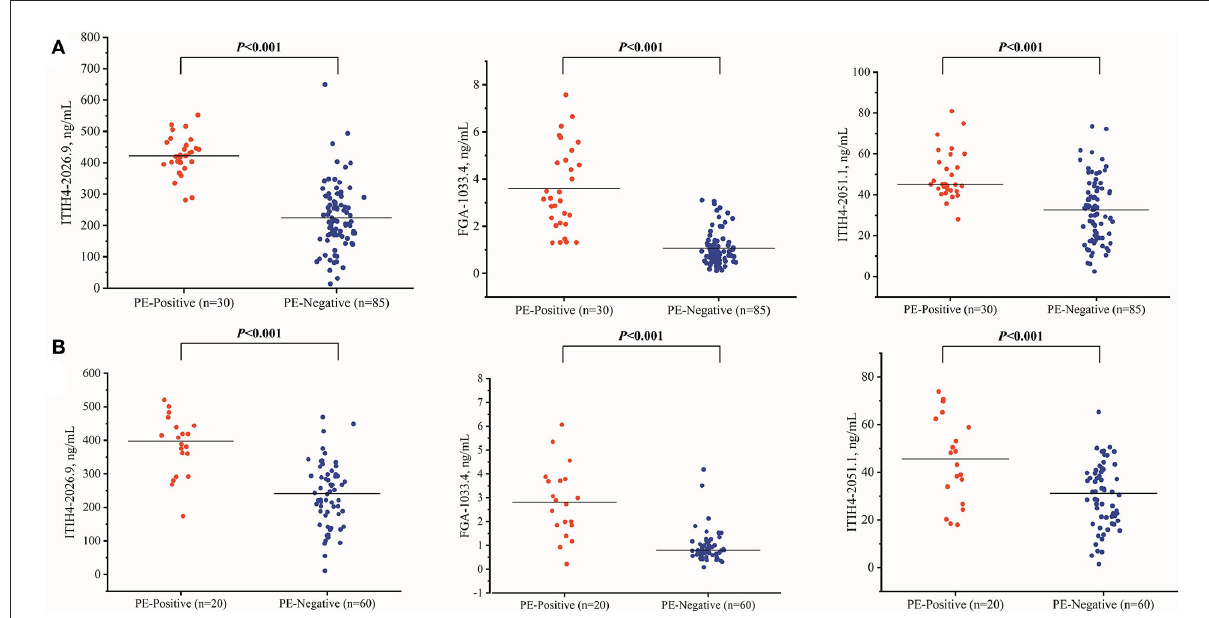
FIGURE2 The three peptide candidates quantitation of the PE-positive and PE-negative groups in the discovery (A) (PE-positive n = 30, PE negative n = 85) and validation (B) (PE-positive n = 20, PE negative n = 60) cohorts.